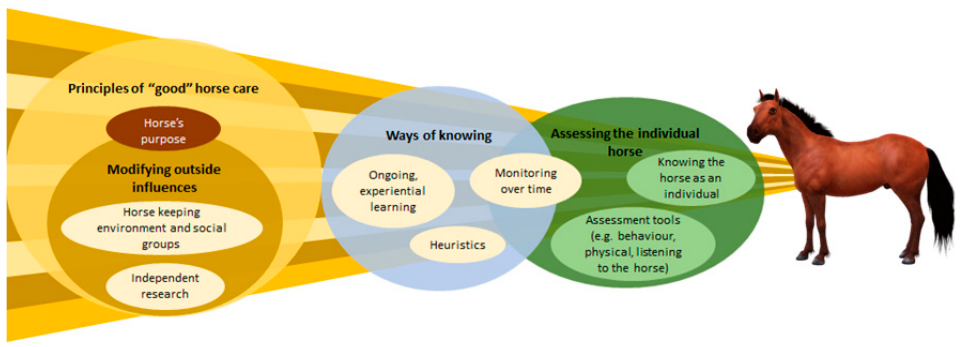
Figure 1. Conceptual model representing themes identified which shaped leisure horse owner’s understanding of a horse’s wellbeing.